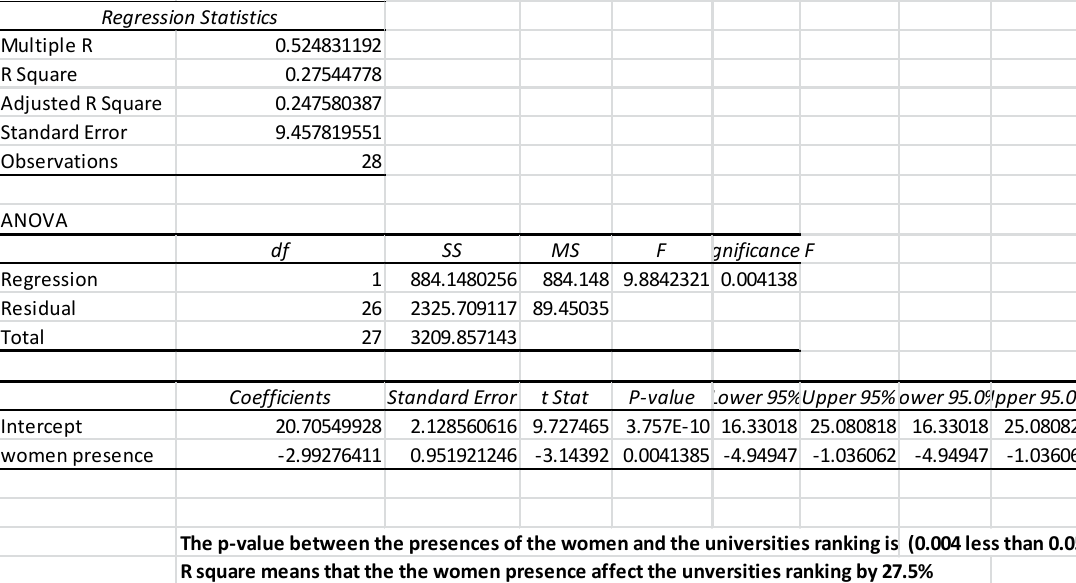
Figure 1. Regression Test.